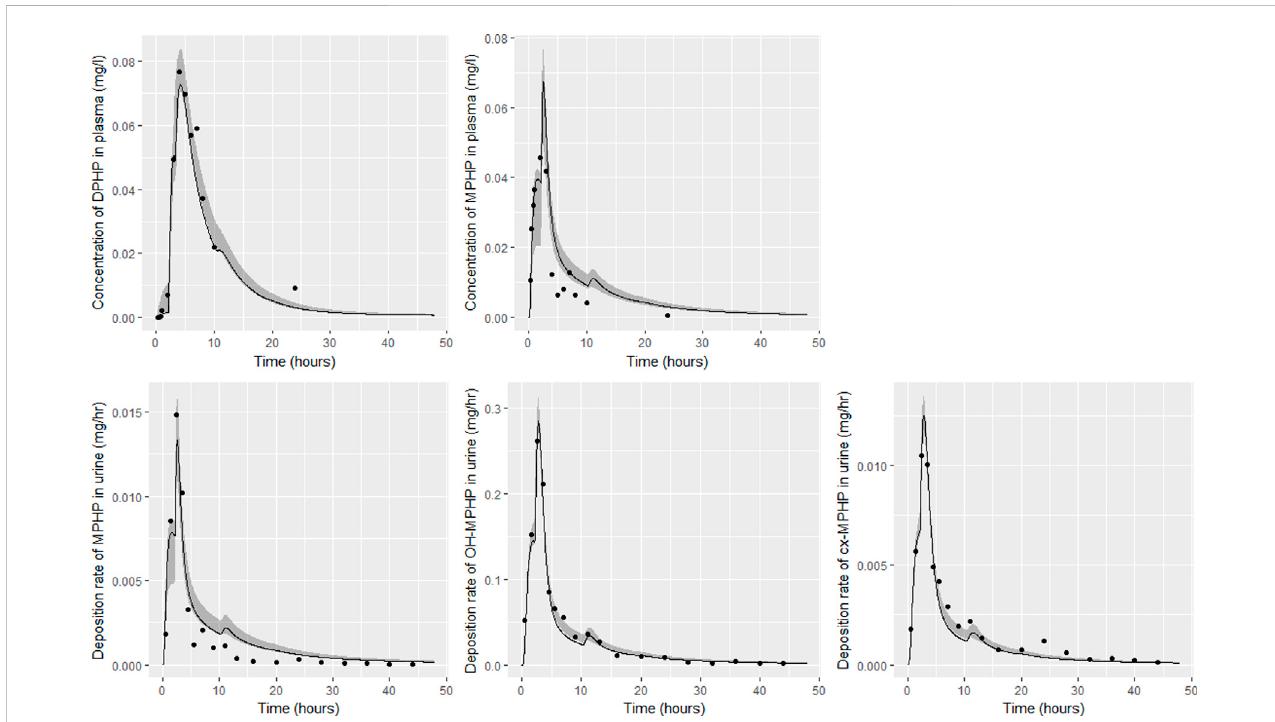
FIGURE 9 Fit of the calibrated model to data from individual (F) . Panel (A) DPHP in venous blood (mg/L); (B) MPHP in venousblood (mg/L); (C) rate of deposition of MPHP into the bladder; (D) rate of deposition of OH-MPHP into the bladder; and (E) rate of deposition of cx-MPHP into the bladder. The central estimates indicated in plots correspond to the posterior mode whereas the shaded regions represent 95% intervals for the respective